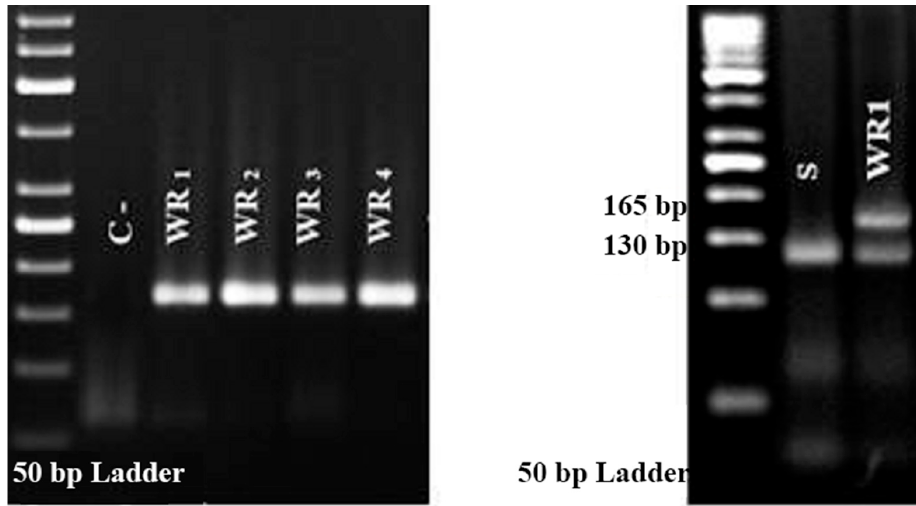
Figure 2. Polymerase chain reaction (PCR) ( Left ), and dCAPS analysis of individual Avena sterilis ssp. ludoviciana ( Right ). The size of the restriction enzyme (NsiI) digested fragment is 165 bp.